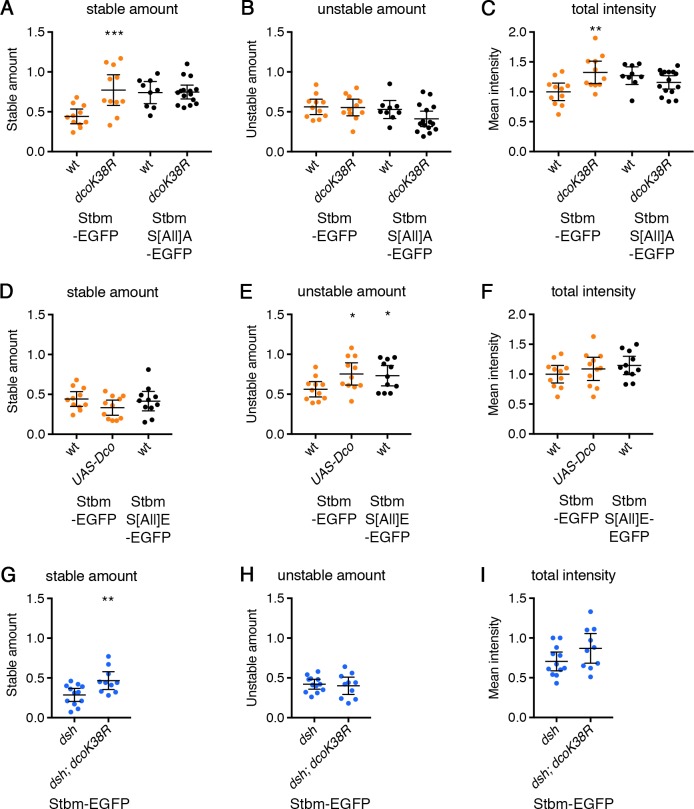
FRAP analysis of Stbm in dco mutant backgrounds.Stable amounts (A,D,G), unstable amounts (B,E,H) or total amounts (C,F,I) of EGFP-tagged protein, in 28 hr APF pupal wings after hub-and-spoke FRAP (see Figure 5A–C). Data are normalised to the total intensity in Stbm-EGFP and error bars are 95% confidence intervals. (A–C) ANOVA with Holm-Sidak’s multiple comparisons test was used to compare pairs of samples with and without DcoK38R. (D–F) ANOVA with Dunnett’s multiple comparisons test was used to compare with the Stbm-EGFP control. (G–I) Samples were compared using an unpaired t-test. p≤0.05*, p≤0.01**, p≤0.001***.